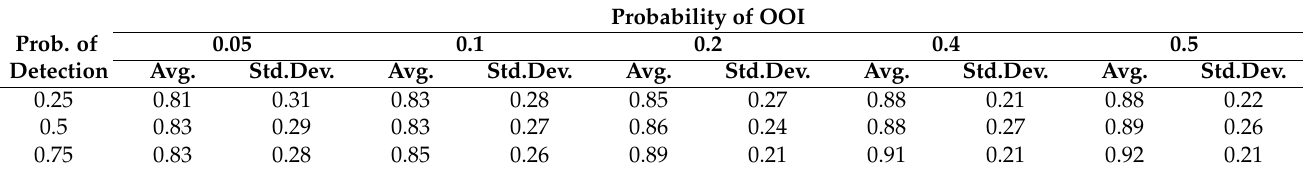
Table 3. Impact of OOI detection on navigation and localization (summary of final index values I ). Probability of